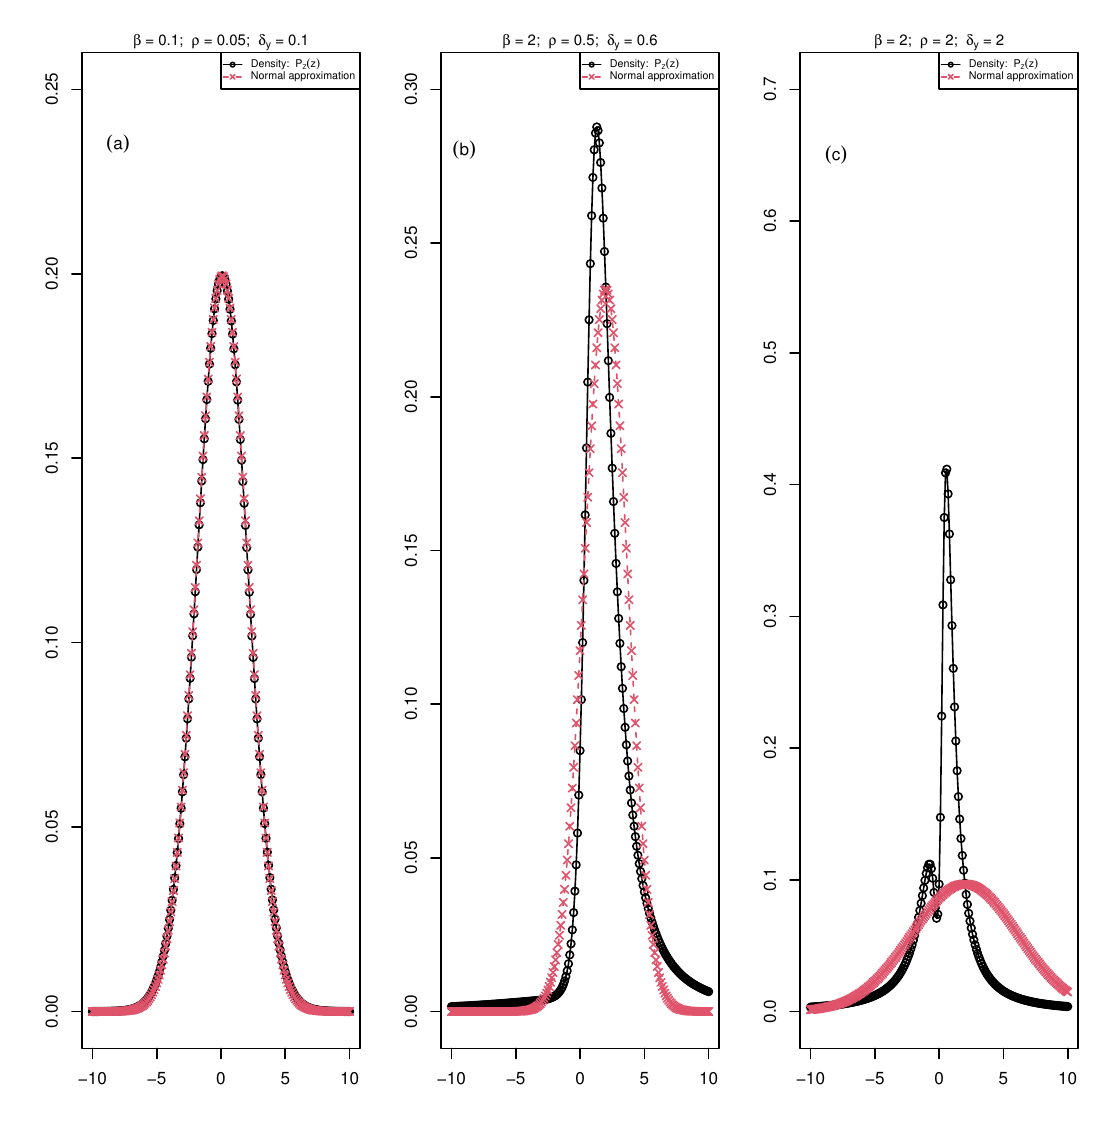
Figure 2. The black curve with circle points is the distribution PZ of the ratio F v / F m ( F m maximum fluorescence and F v = F m − F 0 , F 0 minimum fluorescence) for an increasing values of the parameters, β , ρ , and δ y and the red curve with crossed points is the normal approximation of the distribution in each of these cases. ( a ) A case with perfect fit of the ratio density and the normal approximation; ( b ) a deviation from normal distribution; ( c ) a case where the ratio density is bimodal and the normal approximation is not